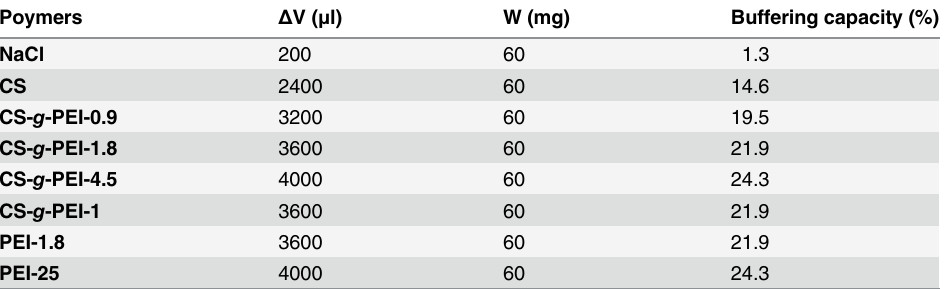
Table 2. Buffering capacity of CS, CS-g-PEI copolymers, PEI-1.8 and PEI-25 measured by acid-base titration.